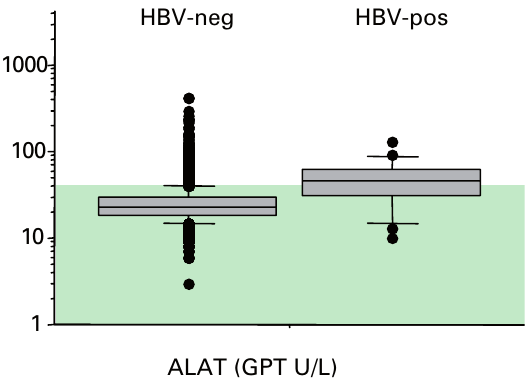
Liver cell destruction a consequence of chronic active hepatitis? Draftees are divided into those who showed labor- atory signs of hepatitis B and those who did not. Although patients with chronic active hepatitis B had higher mean ALAT values, higher individual ALAT values were found among the group of patients without hepatitis